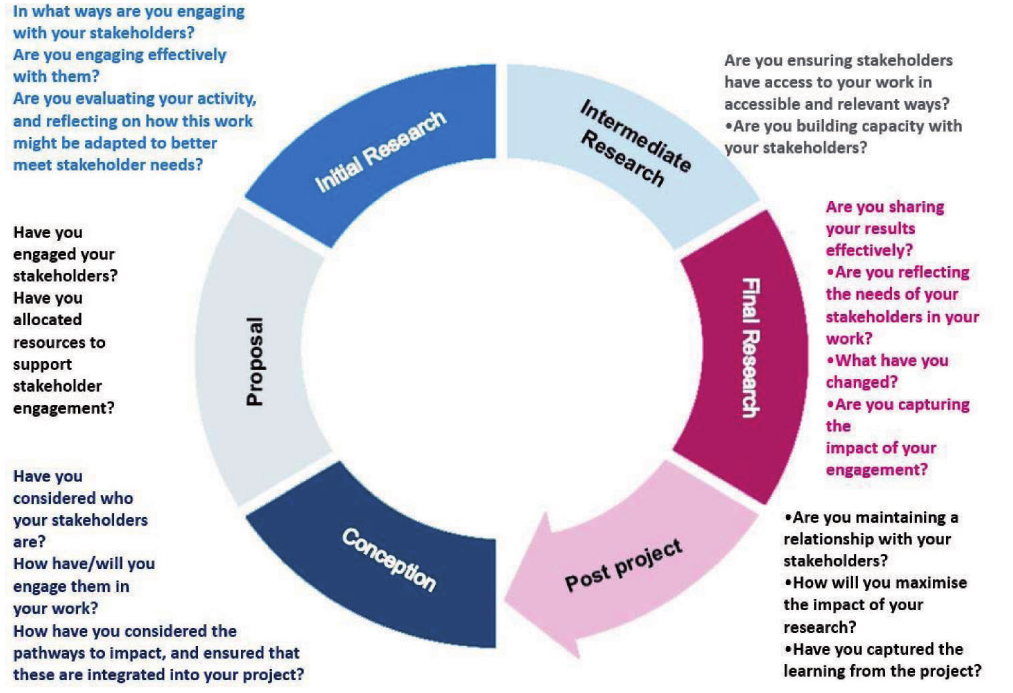
Figure 2: Thinking about when in your research cycle to engage